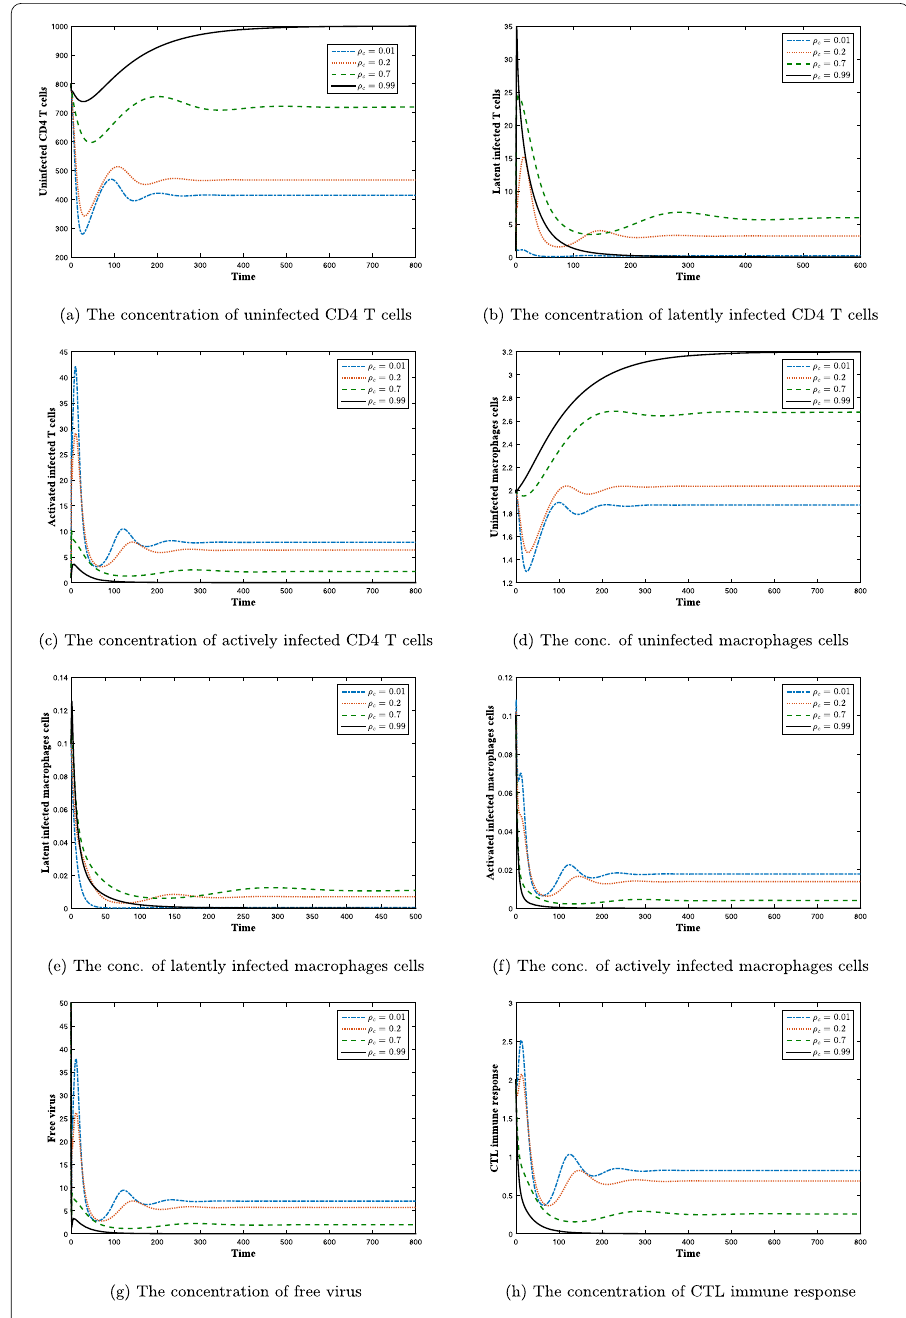
Figure 4 The evolution of model (6)–(13) with varied ρ c